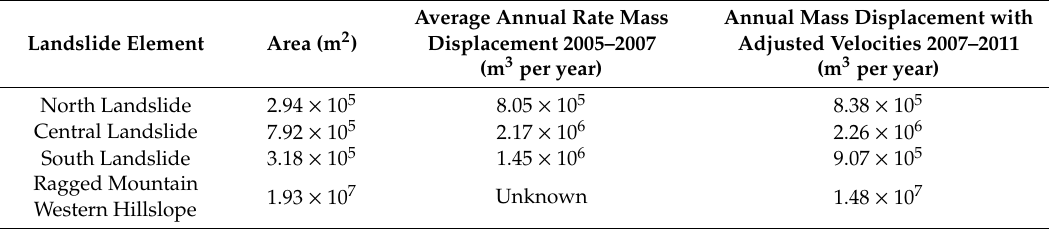
Table 3. Mass wasting estimates of landslide elements from previous and ALOS